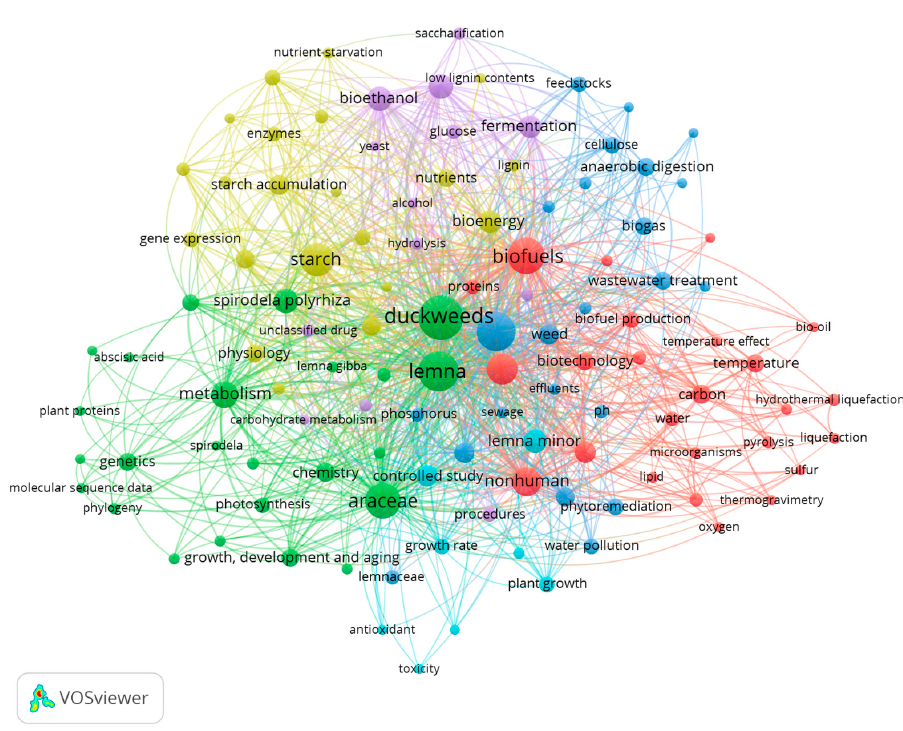
Figure 13. Co-occurrence of author’s keywords–network. The first cluster (red) refers to hydrothermal liquefaction, pyrolysis, and bio-oil pro- duction. The second one (green) reflects the researchers’ focus on growth development using genetics, and the third one (blue) refers to anaerobic digestion and biogas, wastewater treatment, bioremediation, and phytoremediation. The fourth cluster (yellow) shows an interest of scientists in examining duckweed as an energy crop cultivation in the context of starch accumulation and production. The fifth cluster (purple) reflects studies on ethanol, fermentation, enzyme activity, saccharification, hydrolysis, and carbohydrate metabolism. The last cluster (turquoise) focuses on controlled studies on the toxicity of pollutants and their effect on plant growth. Figure 14 presents a network map with the trend topics according to the keywords used in analyzed documents. The most recent keywords used in publications are indi- cated in yellow, and the oldest are indicated in purple. More recently published studies focused on wastewater treatment, anaerobic digestion, biogas production, feedstock, and phytoremediation. The appearance frequency of keywords is represented by circle size, and their correlation is represented by the distance between two circles.